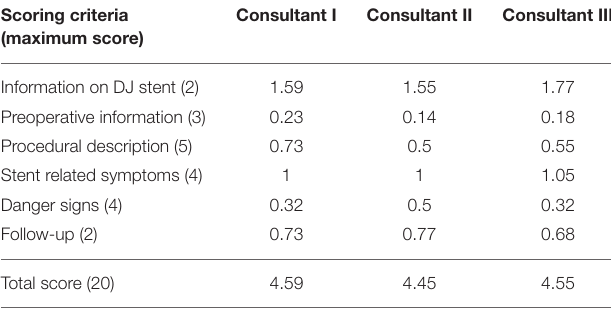
TABLE 3 | Mean scores of each consultant in different scoring